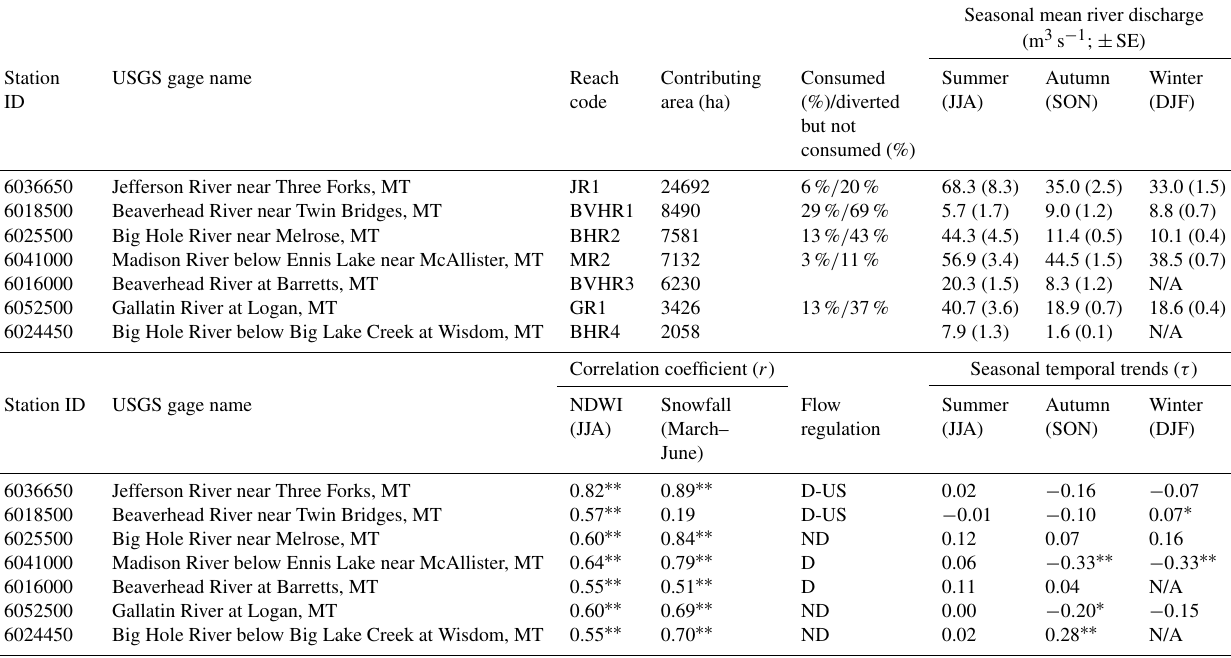
Table 7. River discharge characteristics for the US Geological Survey (USGS) gages used in the analysis. Summer (June, July and August) discharge was correlated with the summer normalized difference wetness index (NDWI) and spring snowfall (March–June) for the riparian reach adjacent to each gage, using the Spearman correlation. Temporal trends were quantified using the Mann–Kendall test for trends. Percentage discharge consumed and diverted is from the 2014 Water Plan (DNRC, 2014). JJA: June, July and August. SON: